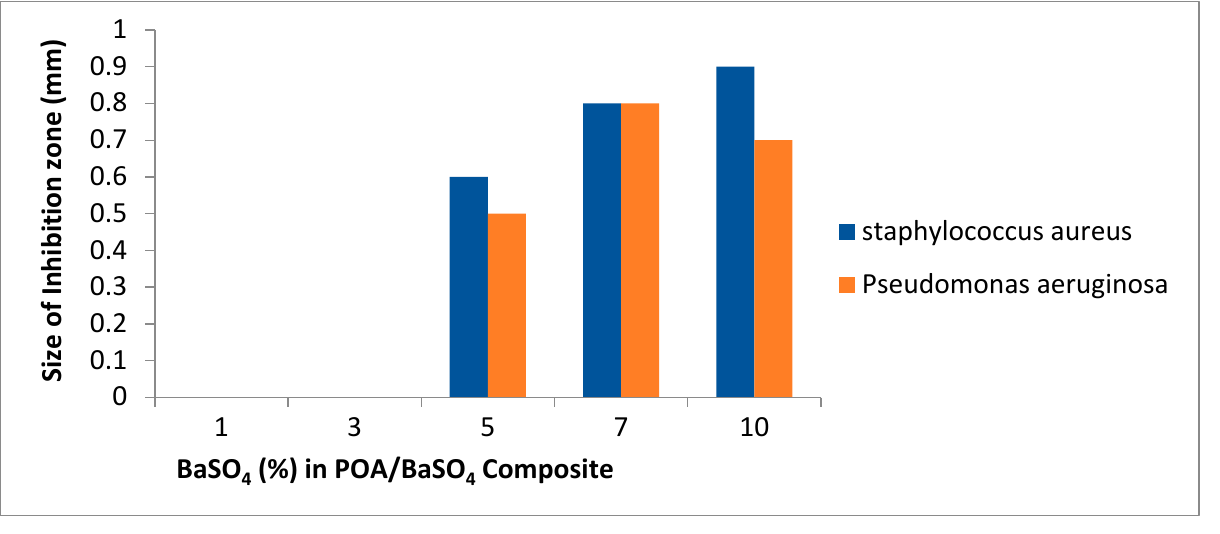
Figure 6. The graph shows the size inhibition zone of BaSO 4 nanoparticles in nanocomposites against load percentage.